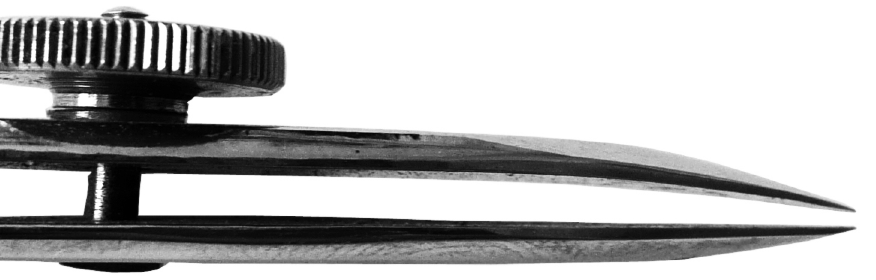
Figure 16. Ruling Pen, Wild Heerbrugg [53].